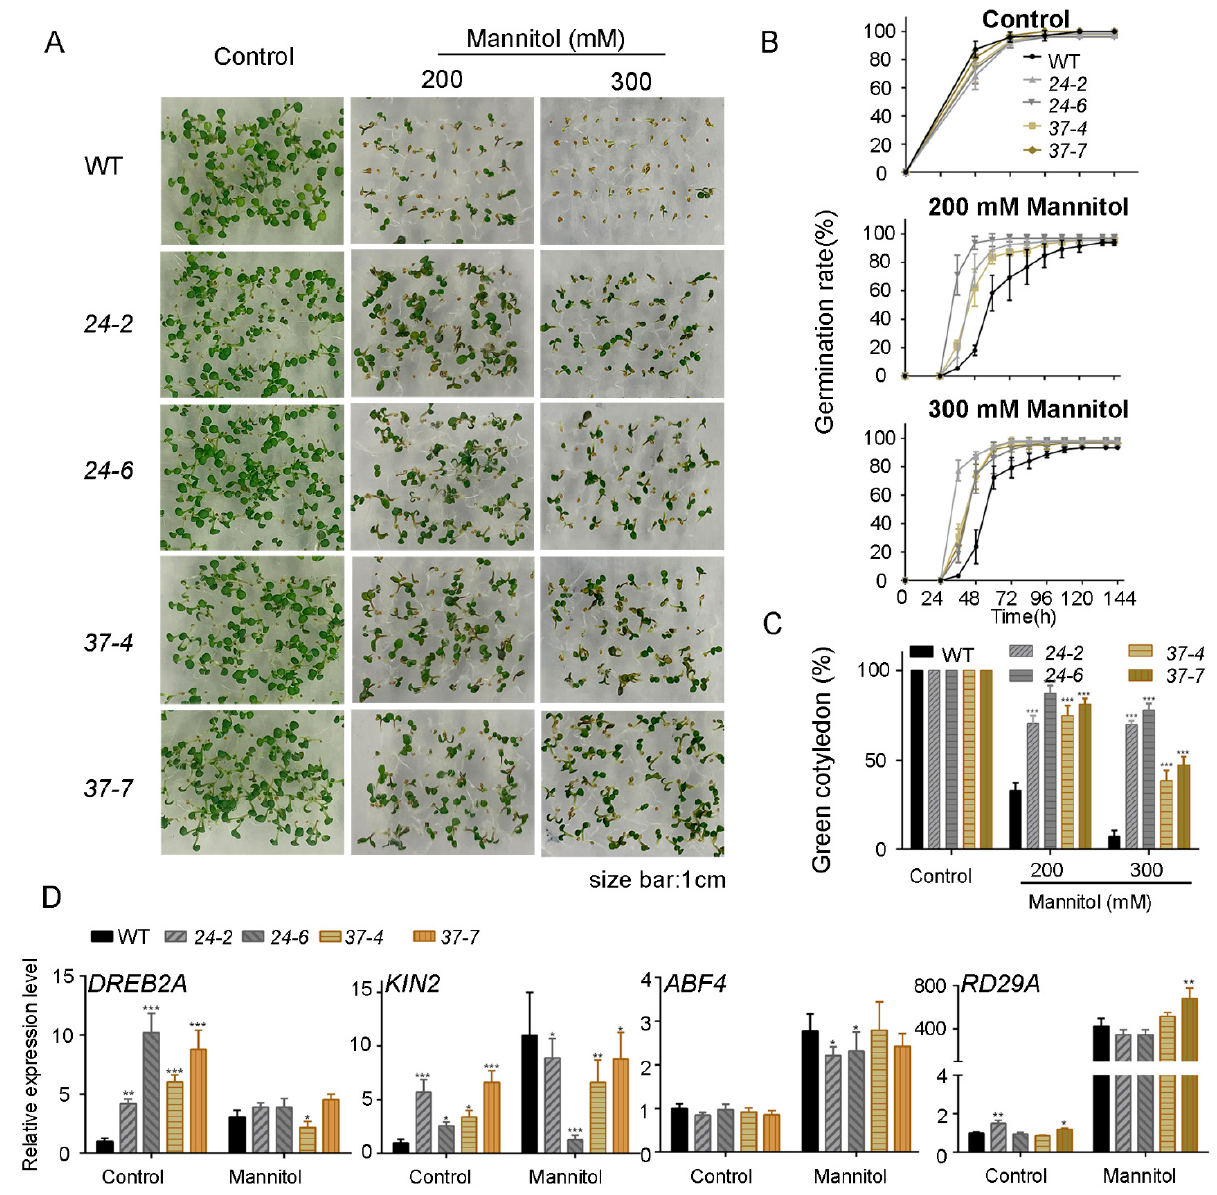
Figure 5. Phenotypic analysis of MdPP2C24/37 overexpression lines in Arabidopsis , which caused a hyposensitive phenotype to mannitol at the seed germination stage. ( A ) Representative images of seed germination. ( B ) Statistical analysis of seed germination rate. ( C ) Cotyledon greening rates of WT and transgenic lines 6 days after seeds were sown in MS medium supplemented with 0, 200, and 300 mM mannitol. Results represent the mean ± SD from 3 independent experiments. ( D ) Real-time qPCR analysis of stress-responsive gene expression changes in the MdPP2C24/37 overexpression lines in Arabidopsis. The expression levels were based on total RNA extracted from WT and transgenic Arabidopsis in liquid MS medium, or liquid MS medium supplemented with 200 Mm mannitol for 3 h. The expression levels are presented as relative units, with levels under control conditions taken as 1. Results represent the mean ± SE from 3 independent experiments, with similar results obtained. Values were significantly different from WT at * p < 0.05, ** p < 0.01 or *** p < 0.001.